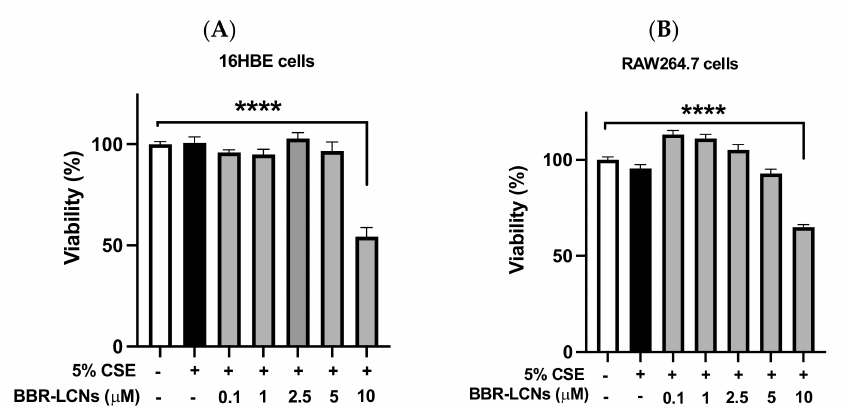
Figure 1. Effect of BBR-LCNs in 16HBE and RAW264.7 cell viability. Cell viability was quantified by MTT colorimetric assay by measuring the absorbance of purple formazan at 540 nm. ( A ) 16HBE cells, ( B ) RAW264.7 cells. **** p < 0.0001 vs control (without BBR-LCNs and 5% CSE treatment). Values are expressed as mean ± SEM, n = 3 independent experiments. Analysis was performed with one-way ANOVA followed by Dunnett’s multiple comparison test. CSE: Cigarette smoke extract; BBR-LCN: Berberine-liquid crystalline nanoparticles.